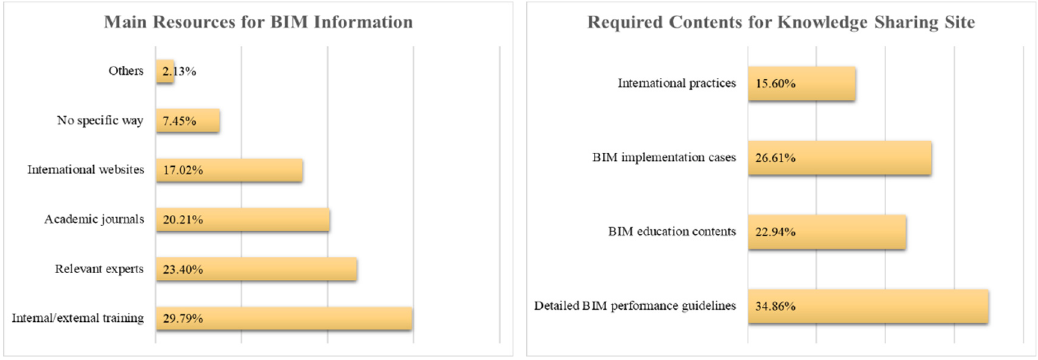
Figure 3. Preferences on BIM Knowledge Sharing Site.